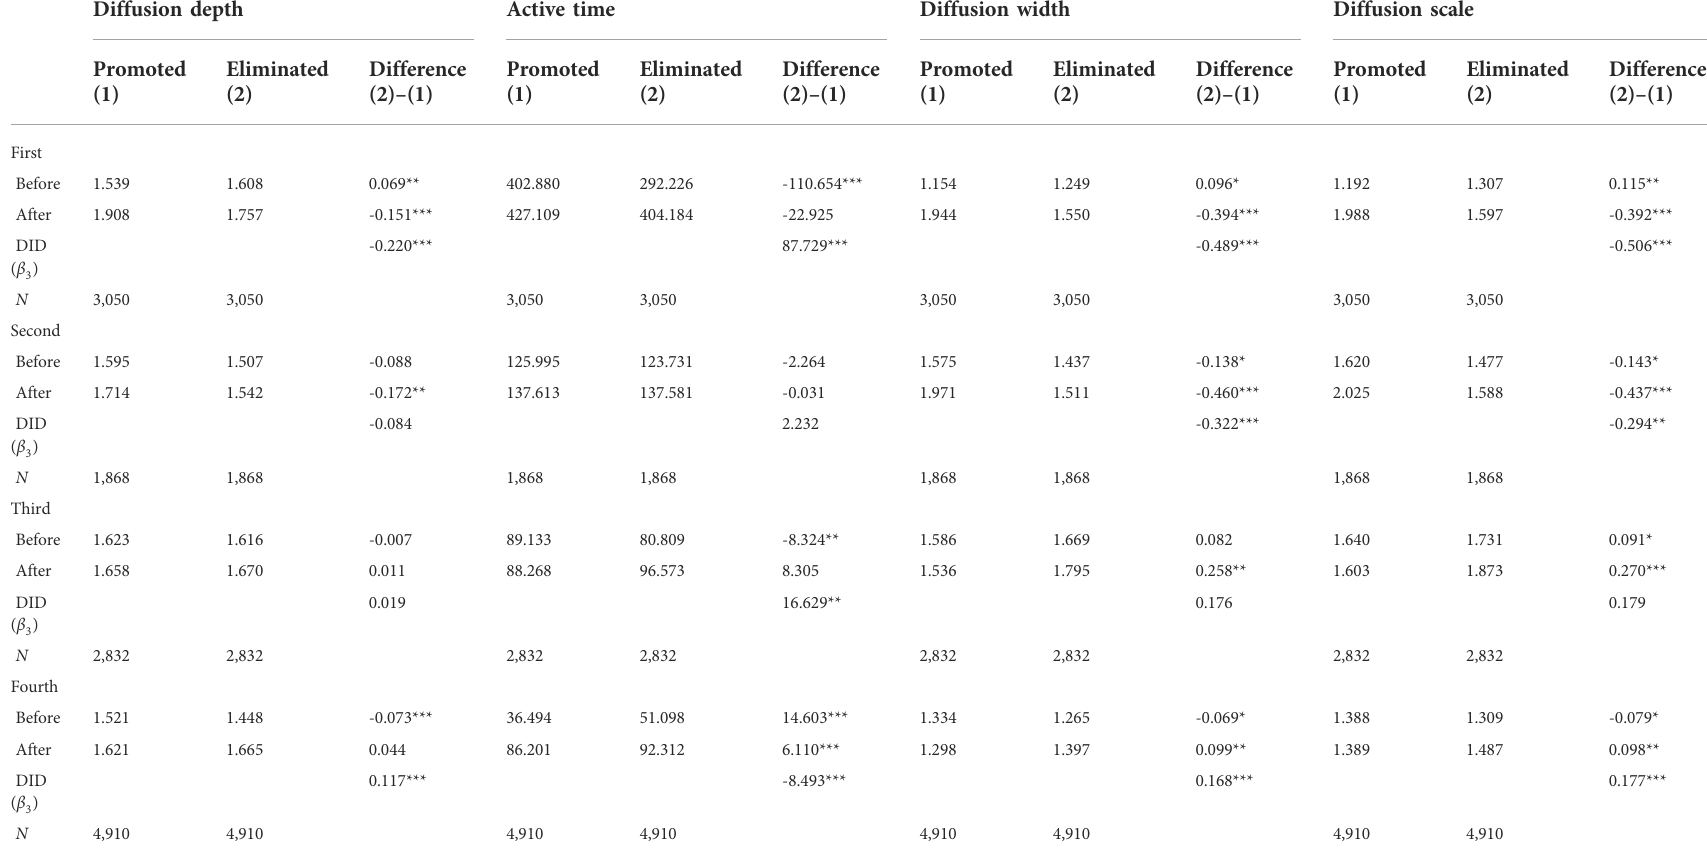
TABLE 1 DID regression results for diffusion tree characteristics for four elimination